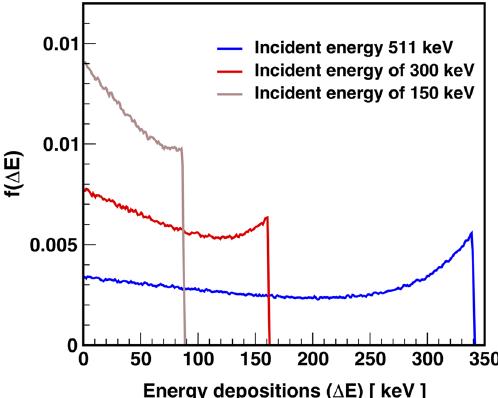
Fig. 10 Normalized Klein–Nishina function describing the probability density distribution of energy depositions by photons of different incident energy in a plastic